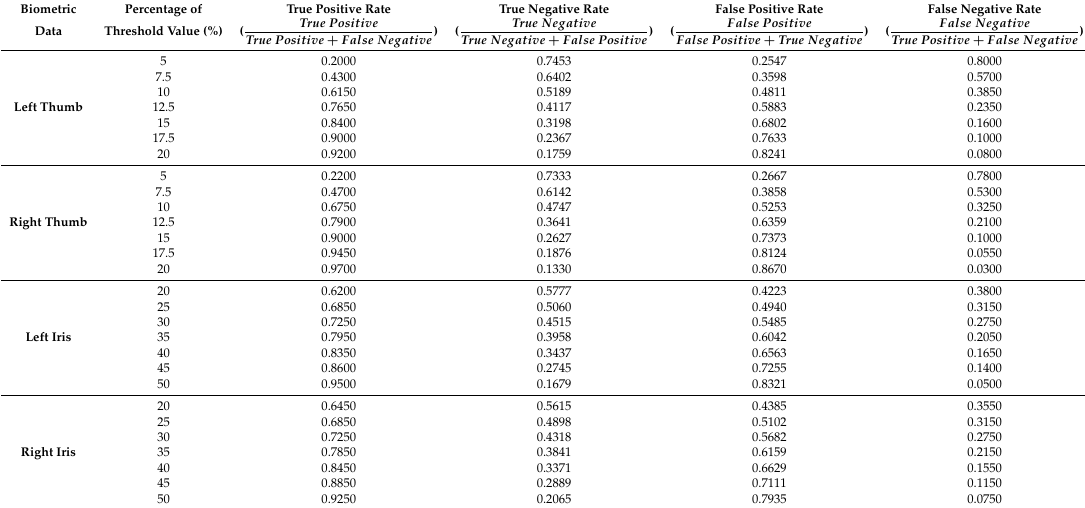
Table 2. Performance Evaluation Results (1): The performance evaluation of the healthy cross-layer biometric recognition system for four biometric datasets.